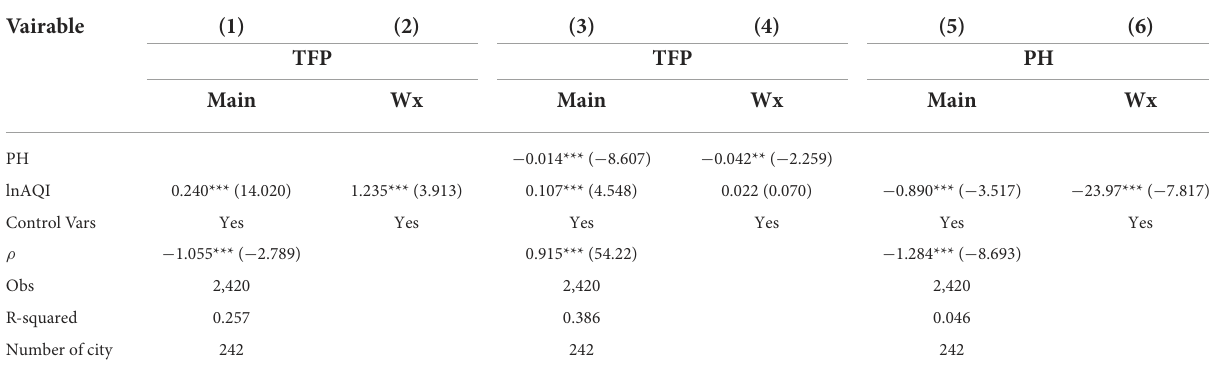
TABLE 17 Thet estimation results of mediating variable—resident health.